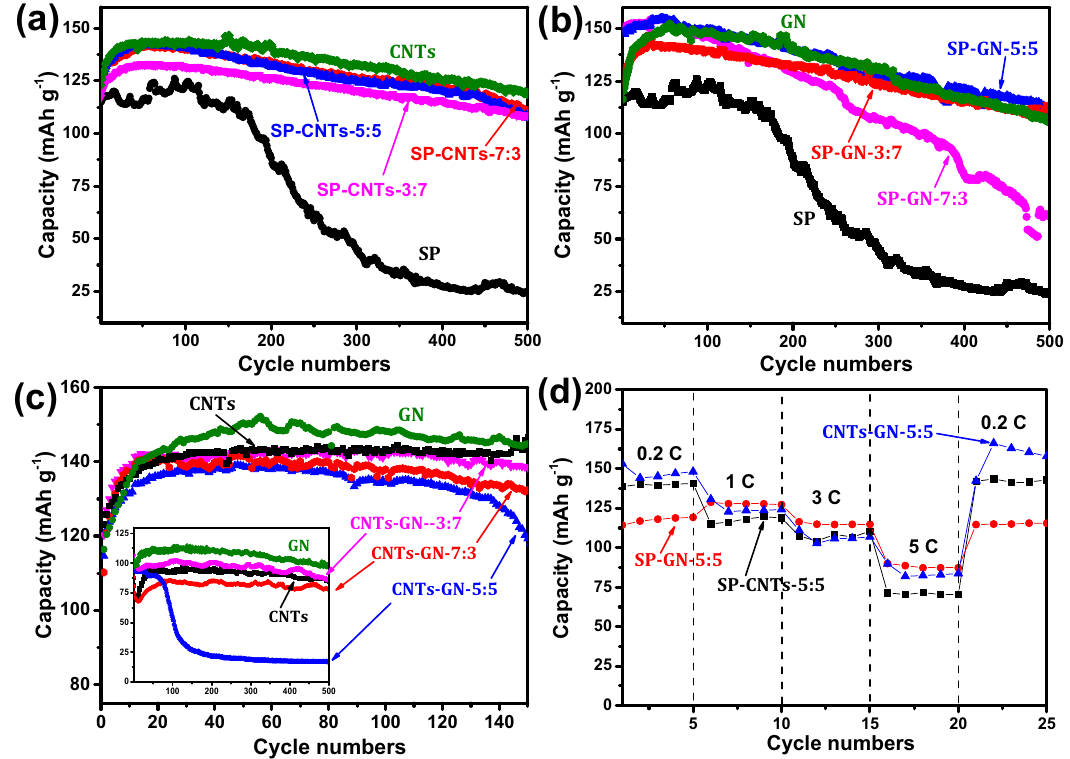
Figure 7: Electrochemical behavior of the LiFePO 4 cathodes with di ff erent binary conductive agents: ( a – c ) cycling performance at 1 C ( the inset is the cycling performance at 5 C ) ; and ( d ) rate performance.